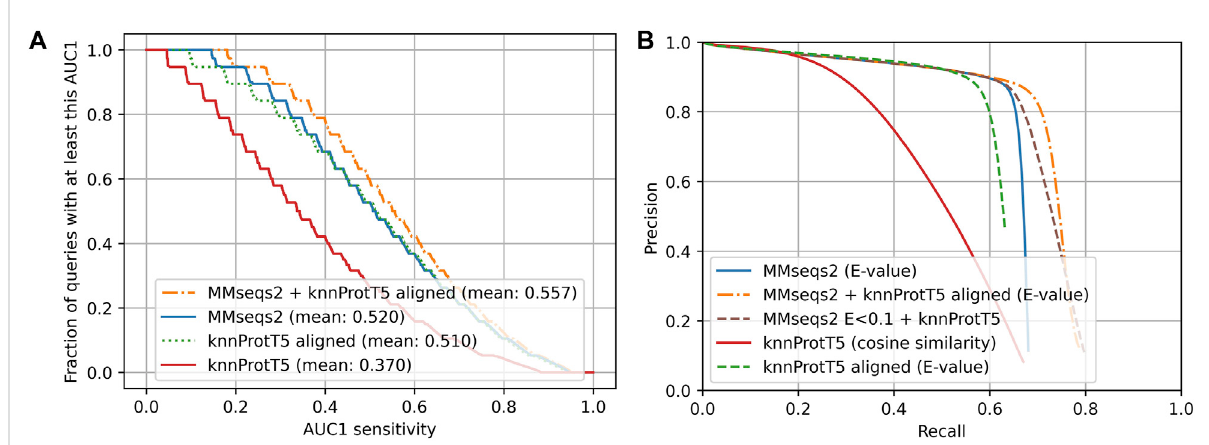
FIGURE 2 Sequence-based approaches better for full-length proteins (Pfam20). Data set: Pfam20; we searched all-against-all through 313,518 proteins with Pfam (Bateman et al., 2000) annotations. (A) Cumulative distribution of AUC1 that for each query re fl ected the fraction of queries (against the 313,518) withamatchingPfam annotation rankedabove the fi rsthitwithoutmatchingPfam annotation. Highercurves impliedhigher sensitivity.The stepsinthelinesoriginatedfromsampling20membersforeachPfamfamily.MMseqs2(SteineggerandSöding,2017)asstate-of-the-artinfast and sensitive sequence-based alignment in solid blue; the novel knnProtT5 method in solid red; knnProtT5 for search plus Smith-Waterman alignment performed by mmseqs align in dotted green; the combination of MMseqs2 and knnProtT5 in dot-dashed orange. (B) Precision-recall curve for the same methods as in panel A except for the dashed green marking an additional test combining unaligned knnProtT5 hits with MMseqs2toshowthepowerofembeddingsontheirown.ThetwocombinedapproachesuseMMSeqs2E-valuesasbaseandknnProtT5withcosine similarity only where MMseqs2 had low E-values. This explains the large overlap with MMseqs2.